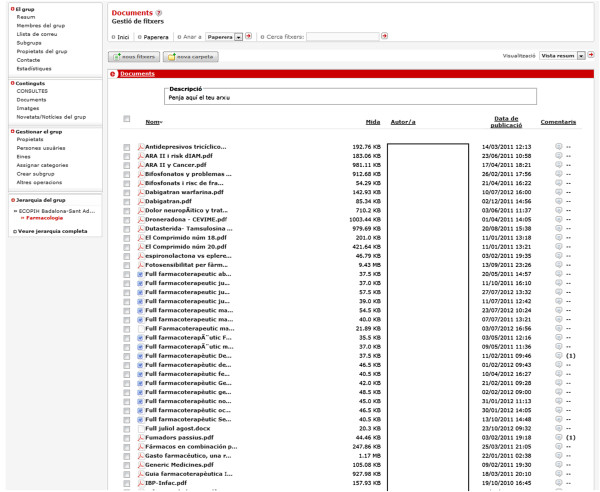
Document repository.